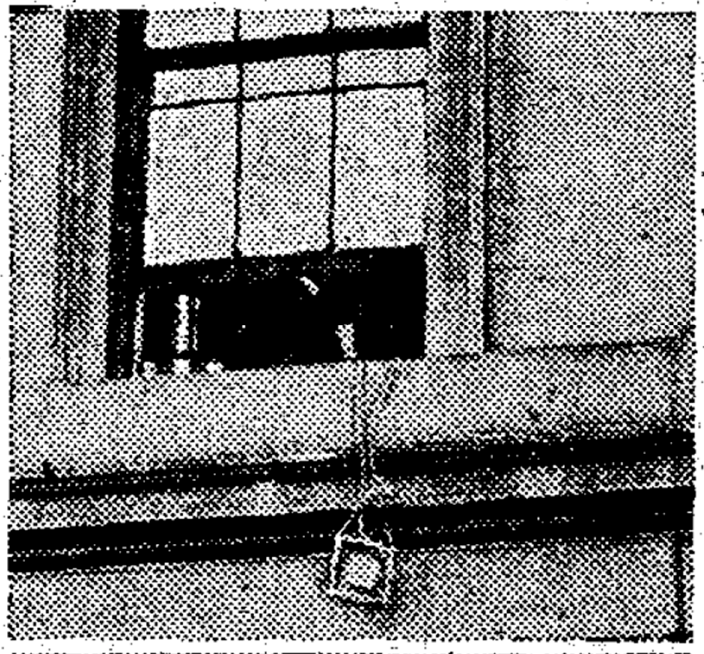
Figure 13. St. George’s Hospital-microphone location.